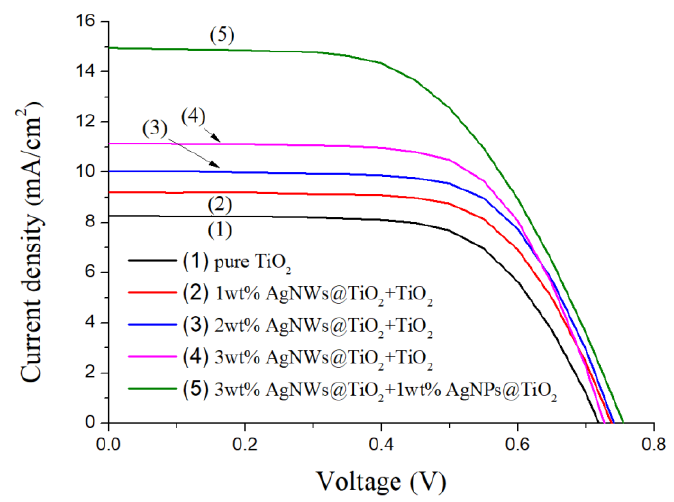
Figure 5. J-V characteristics of different photoanodes.